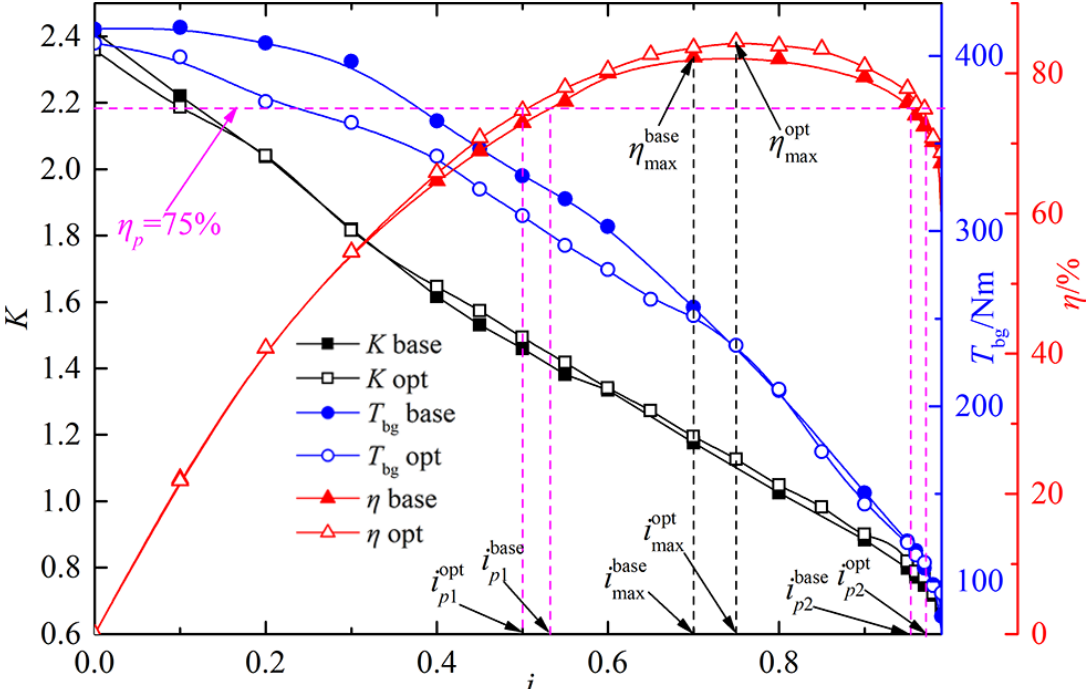
Figure 15. Comparison of the external characteristics of the cascade before and after optimization.